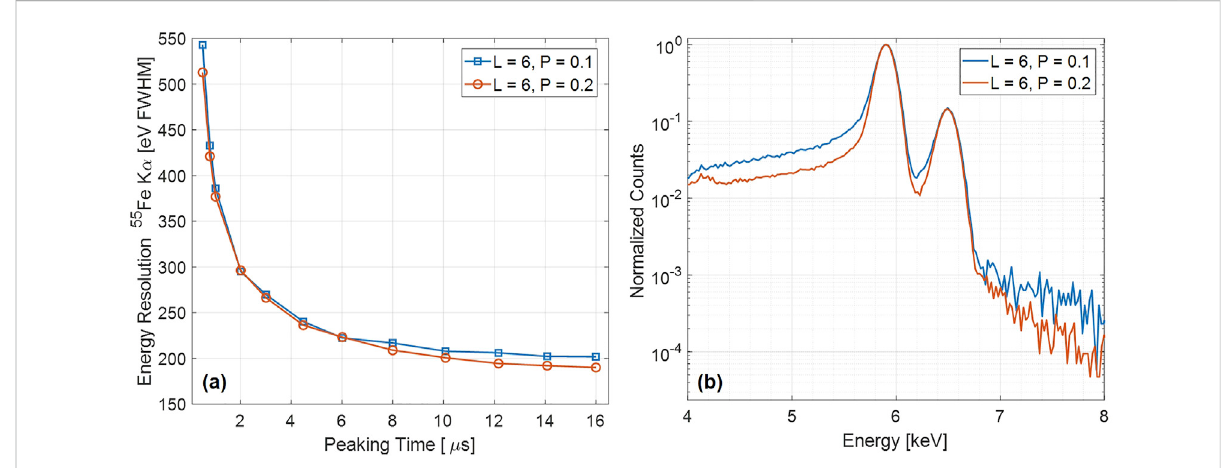
FIGURE 10 Comparison of detectors with different pitch (0.2 in orange and 0.1 mm in blue): (A) energy resolution vs. a sweep of peaking times and (B) spectra of 55 Fe.